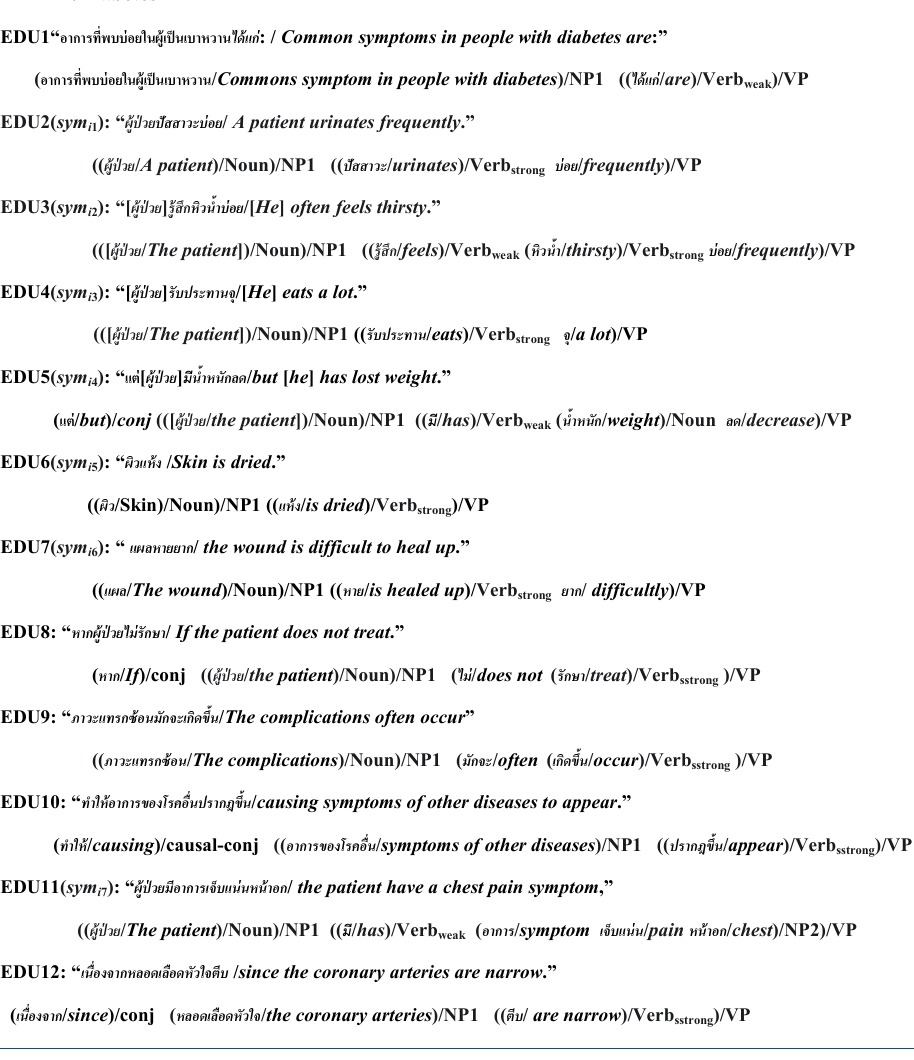
Figure 3. The EDU expressions with symptom concept on the downloaded disease document of Diabetes (where a [...] symbol means an ellipsis of a word/words inside the symbol). English translations for each non-English texts are provided in figure.